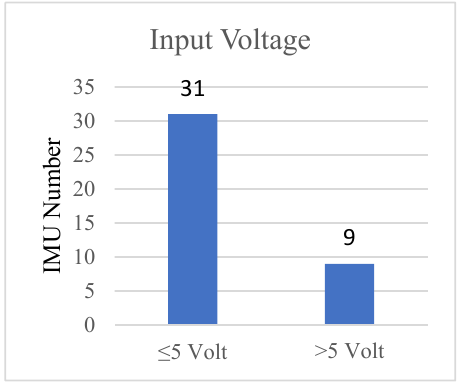
Figure 2. The input Voltage statistics divided in two classes. Most of the models had output data rate below 8000 Hz (26 models, 72.2%). The ESP32 Thing Motion Shield model of SparkFun had the lower value at 80 Hz. Among the others, 9 models (25%), had exactly 8000 Hz. Finally, the ICM-20948 was the only one with 9000 Hz (Figure 3).